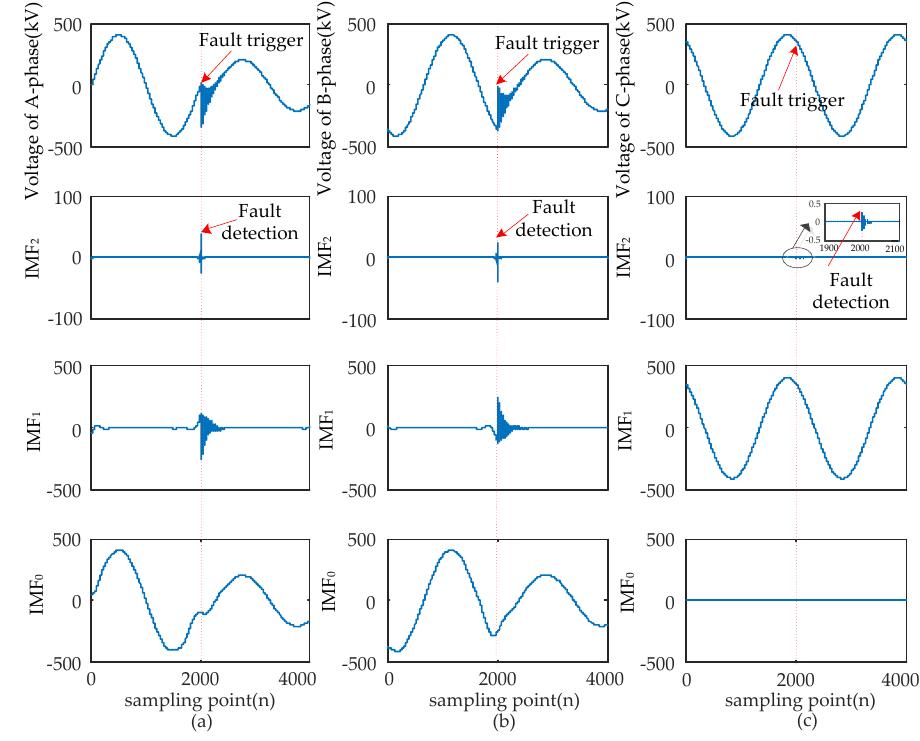
Figure 7. AB fault signal’s modes extracted by the EWT are shown as follows: ( a ) A-phase voltage and its IMFs; ( b ) B-phase voltage and its IMFs; ( c ) C-phase voltage and its IMFs.